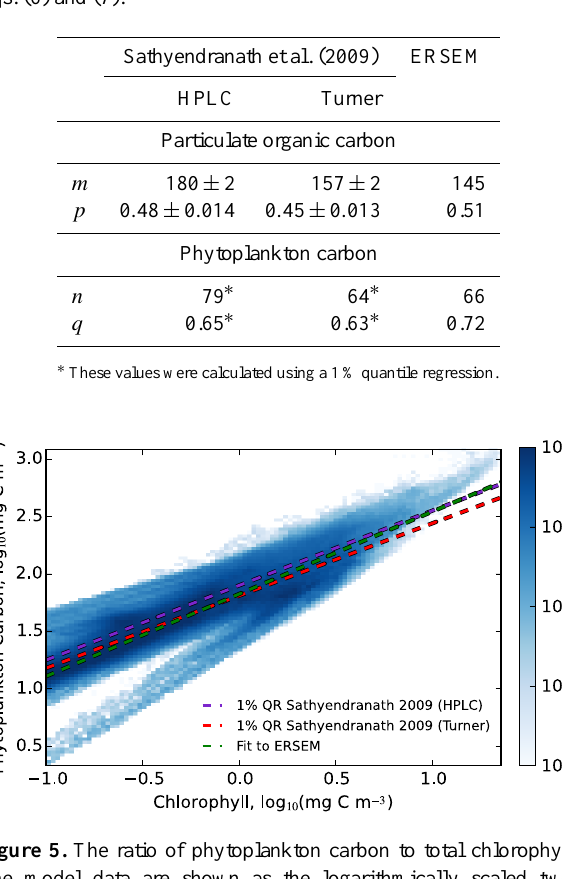
Table 2. The parameters of the particulate organic carbon to to- tal chlorophyll and phytoplankton carbon to chlorophyll fits to the Eqs. (6) and (7).